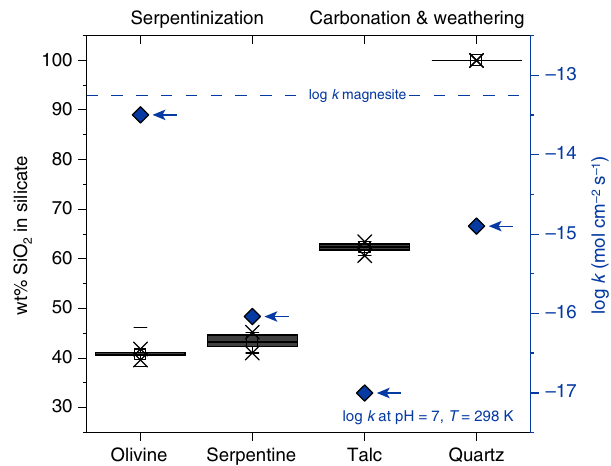
Fig. 3 Solubility of minerals involved in CO 2 alteration of ultrama fi c rock. SiO 2 content and dissolution kinetics of the major silicate phases occurring during ultrama fi c rock alteration compared to the dissolution rate of magnesite at pH 7 and 25 °C. The dissolution rate (diamond markers) is indicated on the right-hand-side axis. The size of the boxes re fl ects the interquartile range of mineral compositions analysed in this